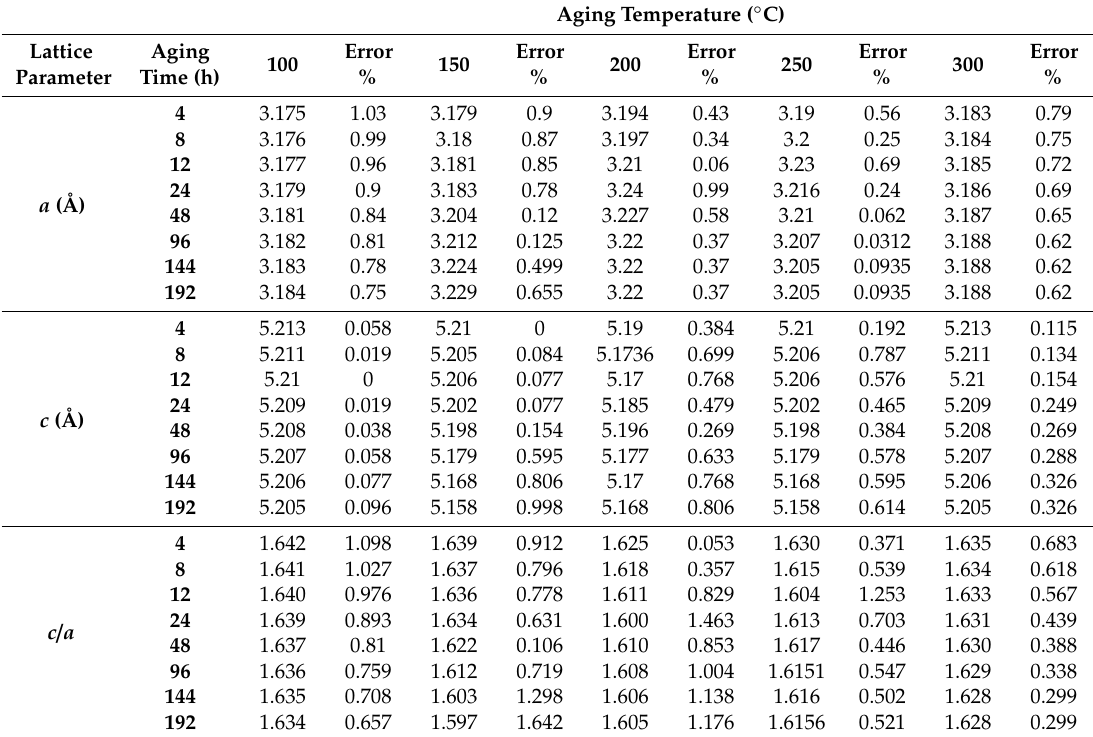
Table 2. The calculated crystalline lattice parameters a , c , and c / a ratio for α -Mg matrix at di ff erent aging temperatures and various aging